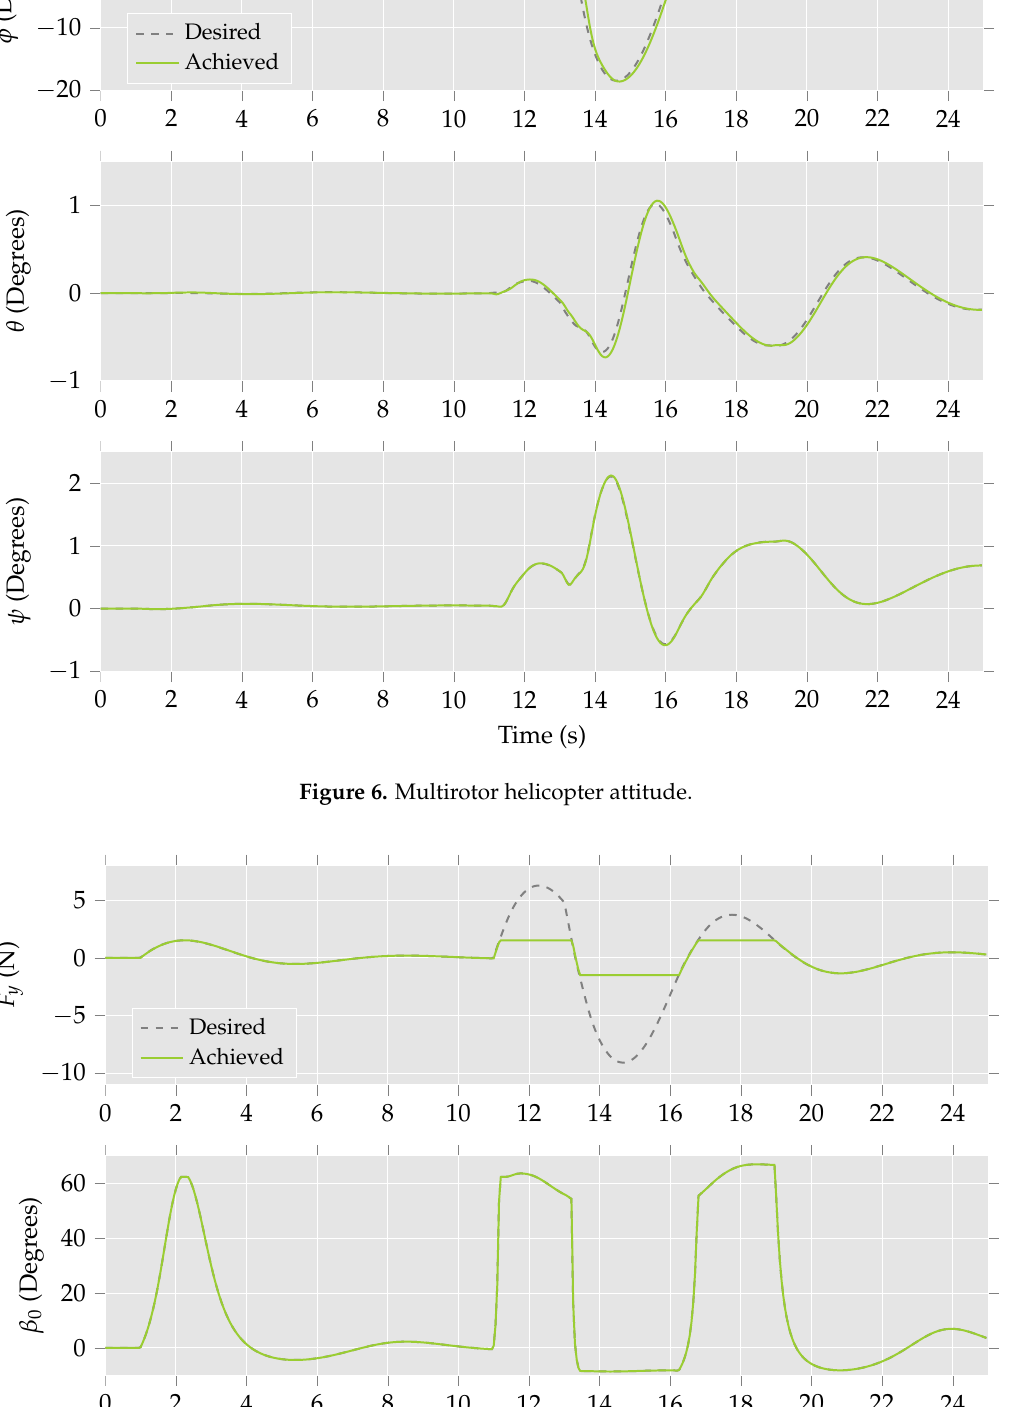
Figure 7. ( a ) Lateral thrust produced by the multirotor helicopter. ( b ) Tilt-rotor tilt angle.